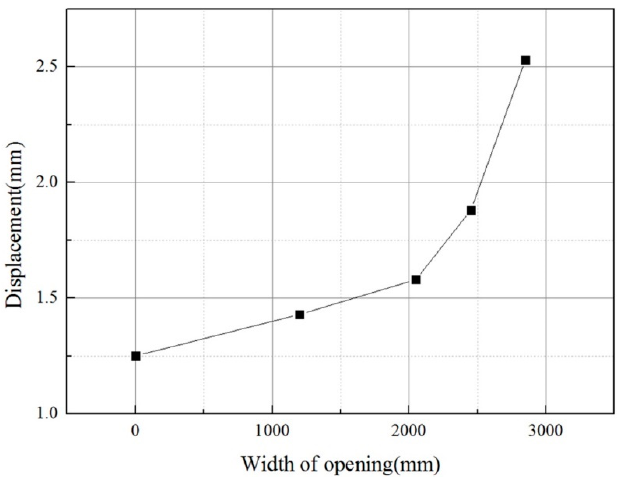
Figure 15. Variation curve of the horizontal displacement at the initial cracking of the interface with the width of opening.